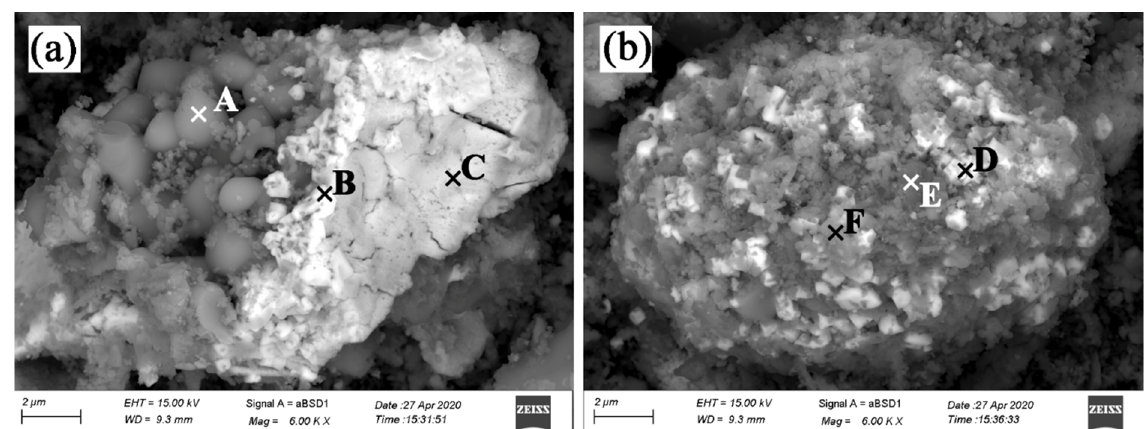
Figure 6. SEM images of the roasted sample of tailings with 10 wt.% MgO addition at 700 ◦ C for 120 min ( a , b ). Table 2. EDS analysis results of points in Figure 6 (wt.%).